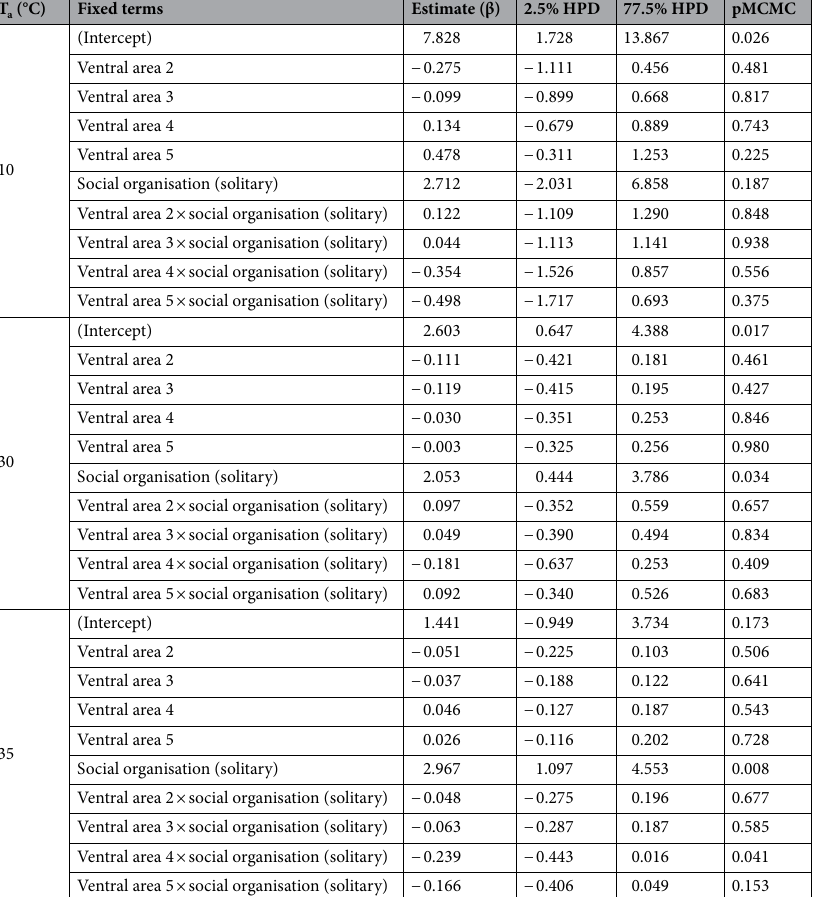
Table 6. Relationships between the difference between core body and surface temperature (T diff ), ventral area (five ventral areas, for details see Fig. 1) and social organisation (solitary vs. social) in seven species of subterranean rodents. 2.5% HPD and 97.5% HPD represent lower and upper highest posterior density intervals; pMCMC denotes to the p value obtained from MCMCglmm; ventral area × social organisation = interaction between ventral area and social